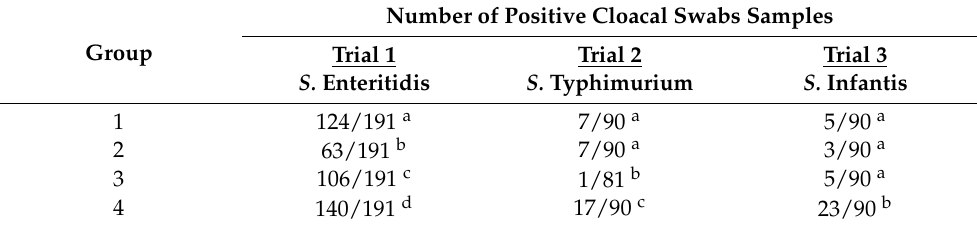
Table 2. Cloacal swabs. Cloacal swabs were taken from all birds on days 3, 6, 9, 12, and 15 post- challenge. In Trial 1, cloacal swabs were also taken on days 2, 4, and 7 post-challenge.